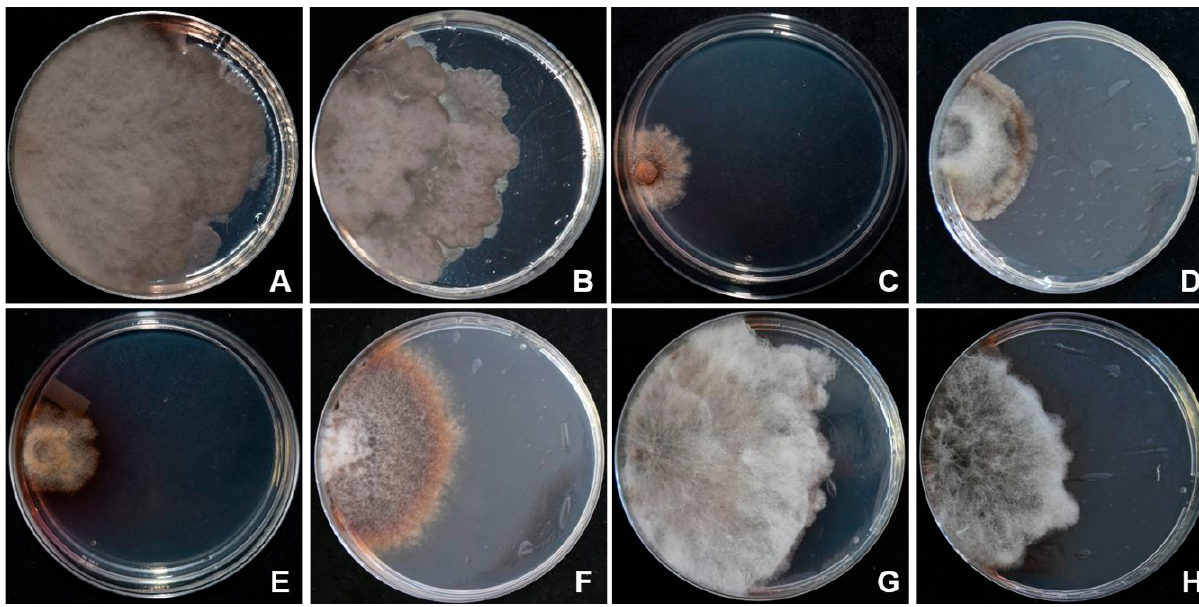
Figure 2. Growth of Lasiodiplodia gilanensis under enzymatic stress conditions. A) Control on PDA. B) PDA + 10 mg mL -1 lysing enzymes of Trichoderma harzianum (LE). C) PDA + 15 μg mL -1 tropolone (Tp), DOPA-melanin inhibitor. D) PDA + LE + Tp. E) PDA + 500 μg mL -1 phthalide (Ph), DHN-melanin inhibitor. F) PDA + LE + Ph. G) PDA + 100 μg mL -1 nitisinone, pyomelanin inhibitor (NTBC). H) PDA + LE +